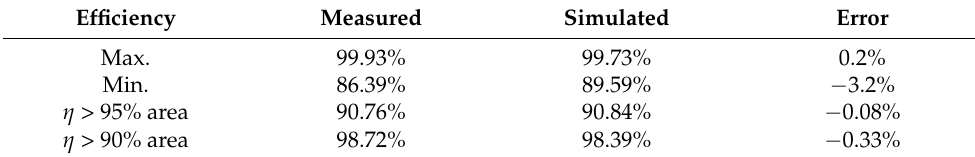
Table 3. Comparison of Measured and Simulated Efficiency Characteristics of the SiC Inverter.